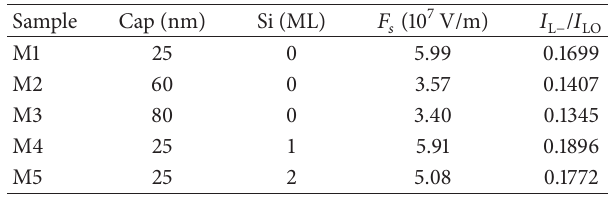
Table 1: Cap layer thickness, surface electric field ( 𝐹 𝑠 ) obtained from PR measurements, and 𝐼 L − / 𝐼 LO ratio calculated from Raman measurements.